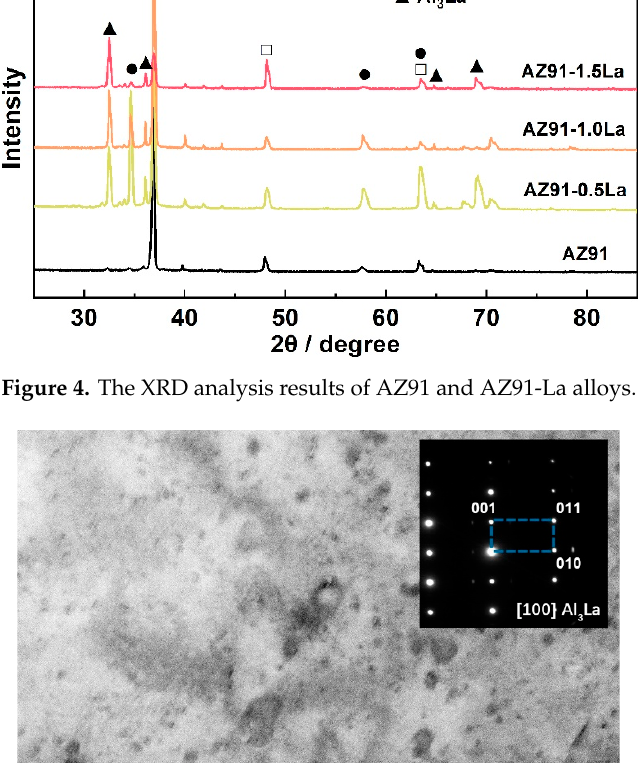
Figure 5. The TEM microstructure of AZ91–1.5La alloy and the selected area electron diffraction pattern of the Al 3 La phase.